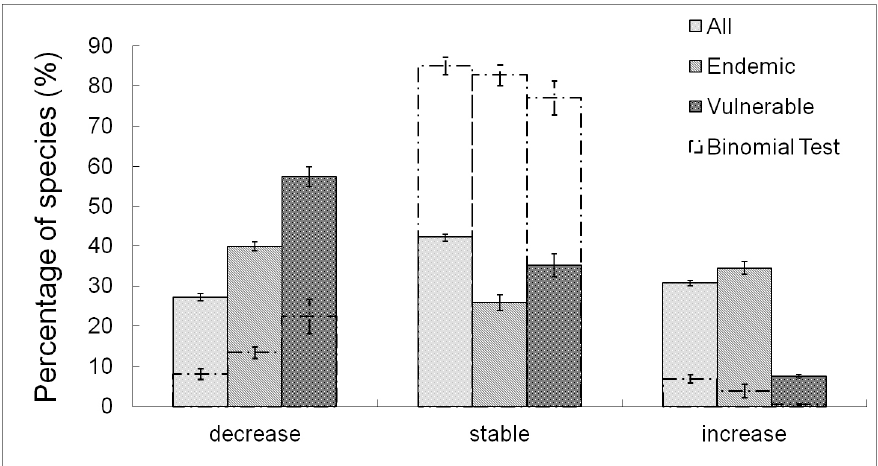
Figure 2. Effect of temperature increase on species distribution. Percentage of species that showed a decrease, an increase, or no variation (stable) of the number of occupied plots. Dash-dotted lines represent the results with the binomial test. Bar charts represent mean values, error bars are the standard errors over model classes and scenarios.